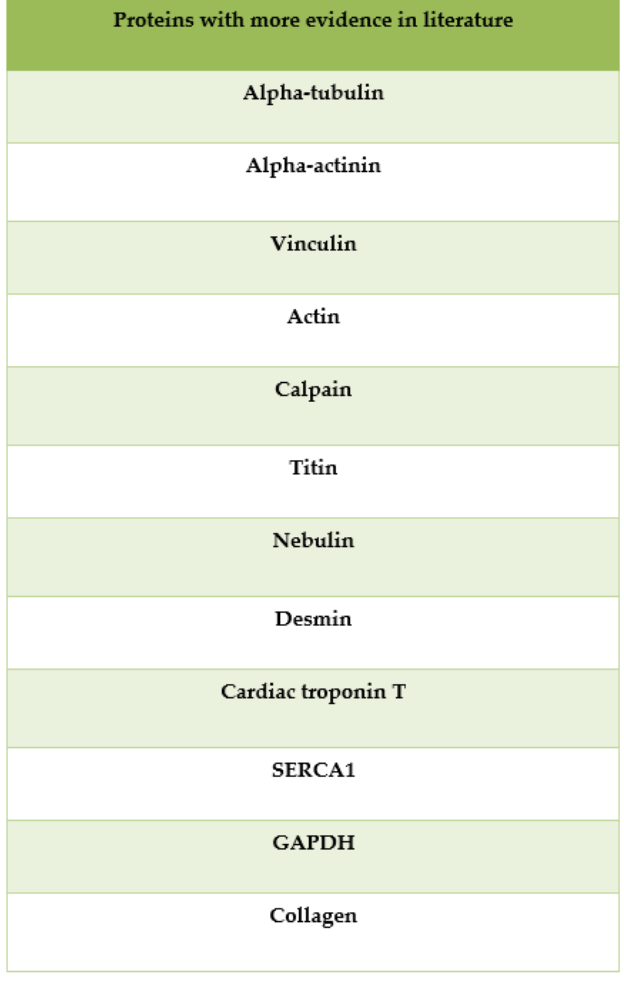
Figure 5. Markers that showed more evidence in the studies selected for